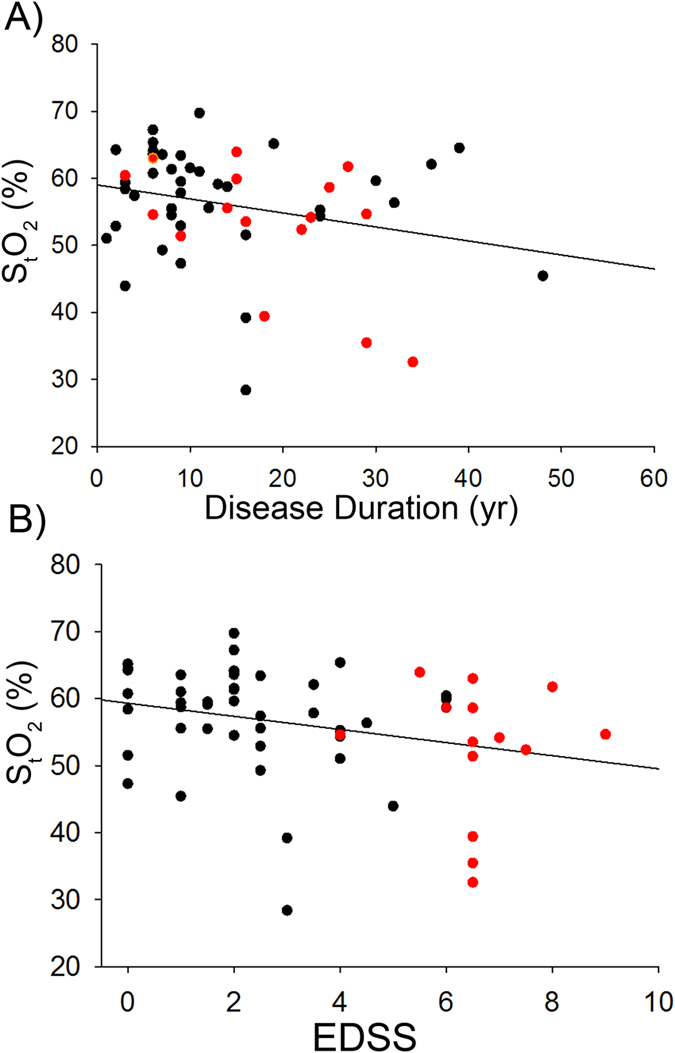
Relationship between StO2 and disability.(A) Relationship between StO2 and disease duration. Red dots denote SPMS patients while black dots denote RRMS patients. There was a significant negative relationship between disease duration and StO2 in RRMS + SPMS patients (p < 0.05, Pearson correlation, r = −0.262). (B) There was a significant negative correlation between StO2 and EDSS scores (p < 0.05, Spearman’s rank test, r = −0.364).